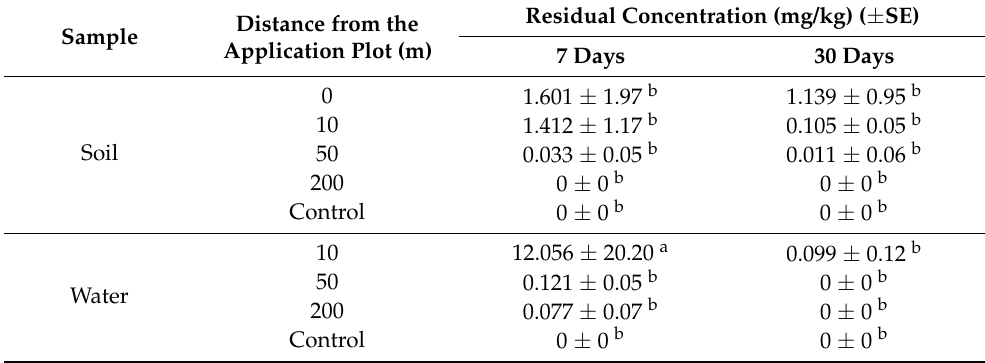
Table 1. Fluopyram residue in soil and water samples after applying the suspension concentrate in the